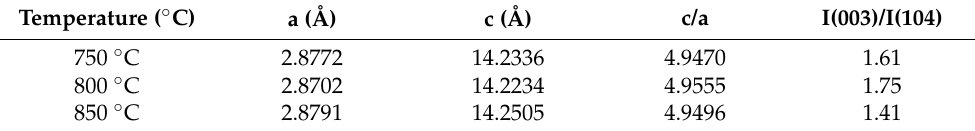
Figure 2. XRD patterns of NCM622 samples with different sintering temperatures. Table 1. Lattice parameters of NCM622 samples with different sintering